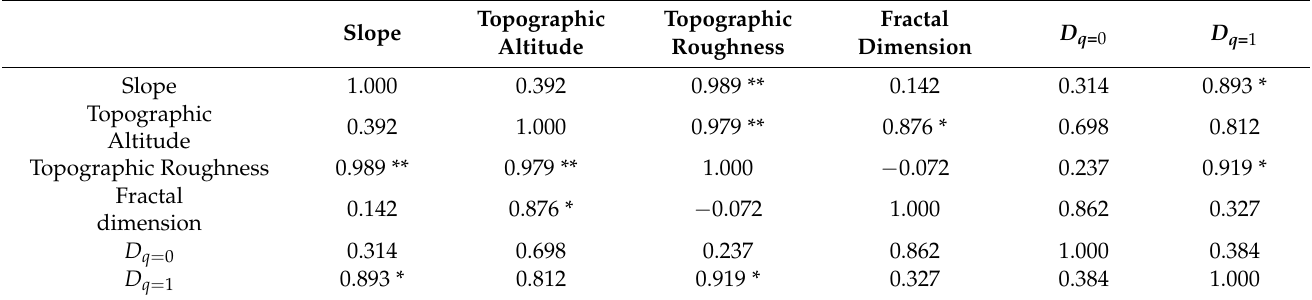
Table 4. Pearson’s correlation coefficients between general terrain parameters and other multifractal parameters.